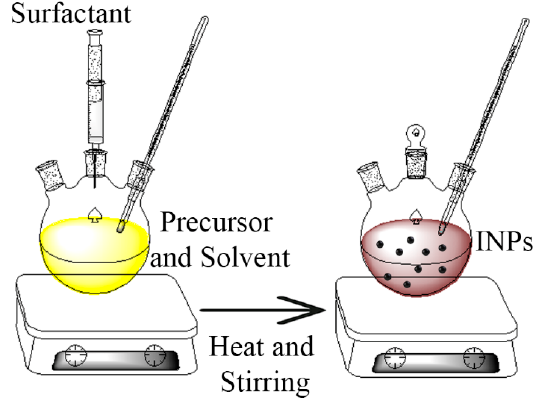
Scheme 3. Schematic illustration of a pyrolysis reaction.